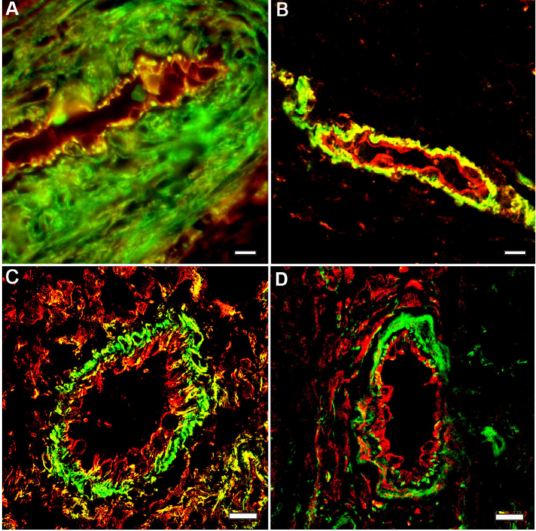
Figure 3. Segregation of cytoplasmic actin isoforms in the endothelia cell in vivo. Capillaries in tissue sections: longitudinal ( A , B ) and cross ( C , D ) tissue sections of the wound healing areas of stratified epithelium of human skin. Immunofluorescence staining of β -actin (green) and y-actin (red): A – C ; β -actin (green) and vimentin (red): D . LSM. Scale bars: 5 µ